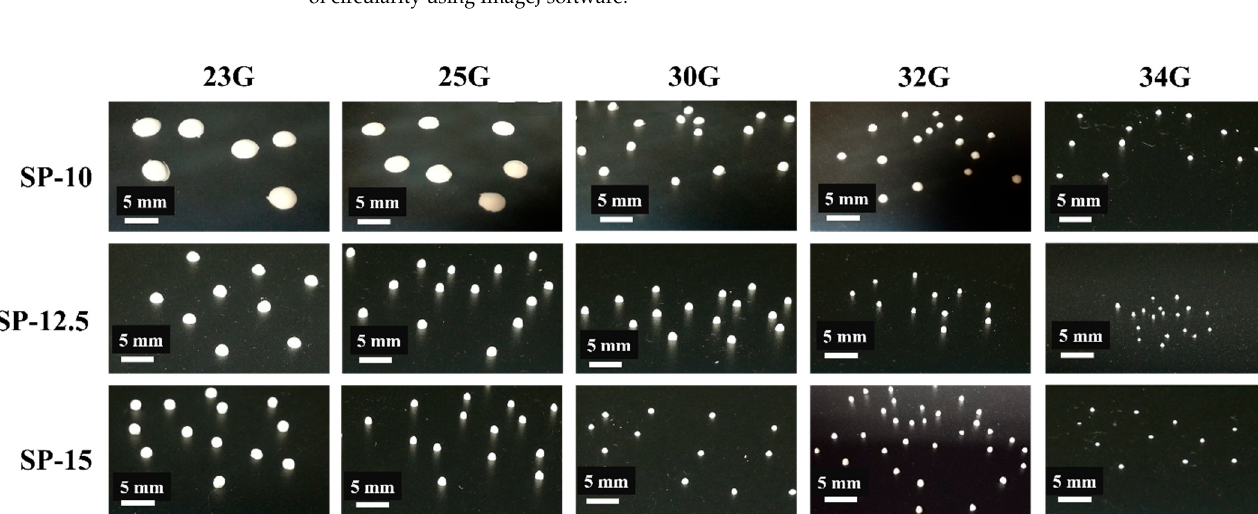
able to form spherical beads (data not shown). Garc í a-Gonz á lez et al. [9] reported that